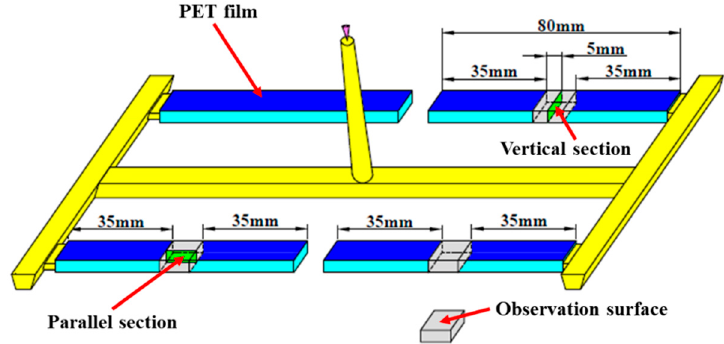
Figure 5. Preparation of samples for SEM observation from flexural samples.